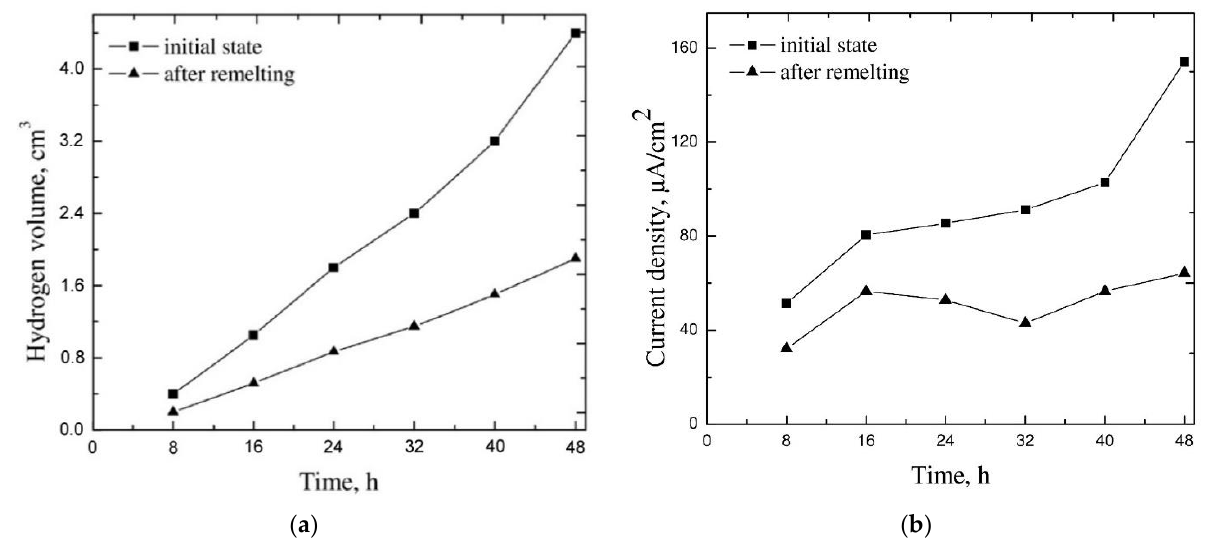
Figure 10. Dependences of hydrogen volume ( a ) and corrosion rates ( b ) on time of immersion in 0.5 mol dm −3 NaCl solution for remelted and non-remelted samples.